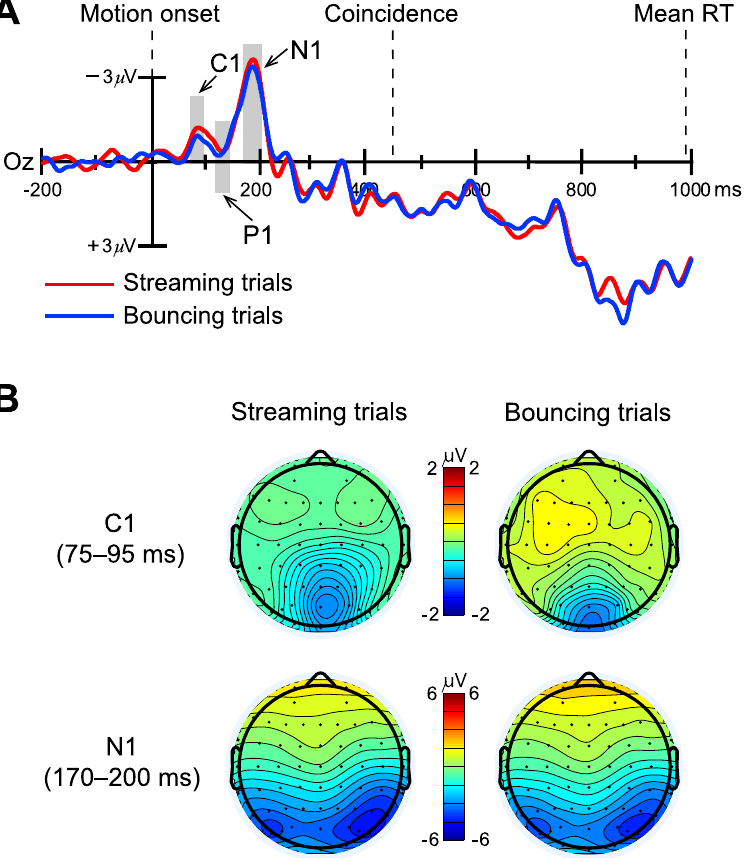
Figure 2. Grand-averaged ERPs associated with the streaming and bouncing percepts over the posterior scalp. ( A ) Three early visual-evoked ERPs over the occipital scalp, C1 (75–95 ms, shaded area, the same below), P1 (120–145 ms), and N1 component (170–200 ms), elicited by the visual streaming/bouncing motion display. Shaded areas show the time windows in which the three components were quantified respectively. Example waveforms shown here are from Oz electrode. Key events in behavioral task [motion onset, coincidence, and mean RTs of all response-required trials (measured relatively to the moment coincidence, i.e., the onset of frame 10)] are shown above the ERP waveforms. The dash line connecting the key events and ERP waveforms indicates they share same time axis in this figure. ( B ) Topographical distributions for the visual-evoked C1 (75– 95 ms) and N1 (170–200 ms) components. Scalp topography within P1 interval was not shown here because P1 on neither streaming nor bouncing trials showed positive amplitude, although both of them did show